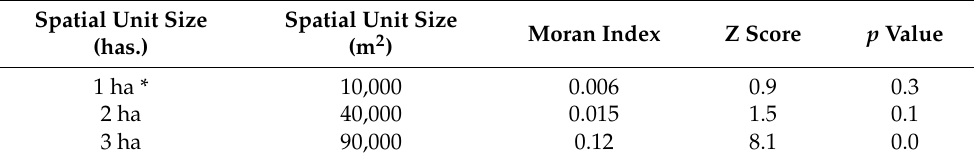
Table 3. Results of the Moran autocorrelation index for different spatial units of density (number of infected per